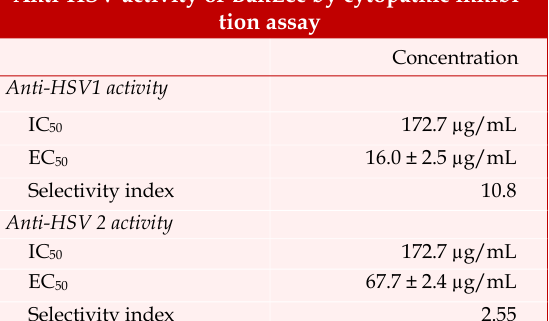
Anti-HSV activity of BanLec by cytopathic inhibi- tion assay